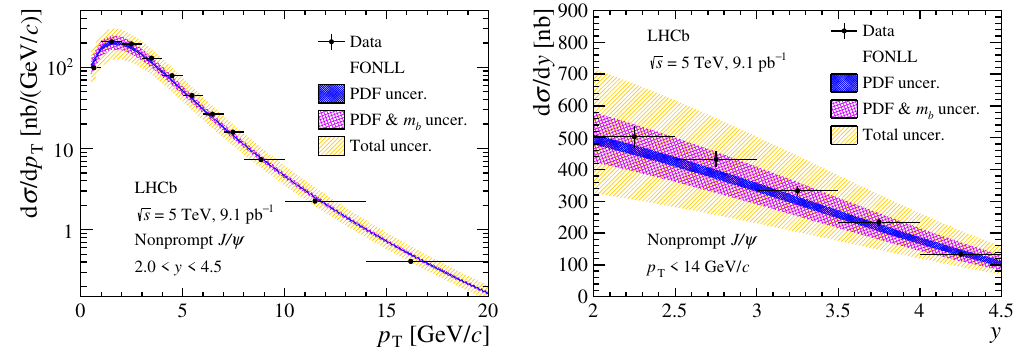
Figure 4 . Differential cross-sections (left) d σ/ d p T and (right) d σ/ d y for nonprompt J/ψ mesons compared with FONLL calculations [58, 59]. The orange band shows the total FONLL calculation uncertainty; the violet band shows the uncertainties of PDFs and that due to b -quark mass added in quadrature; the blue band shows only the uncertainties on PDFs.